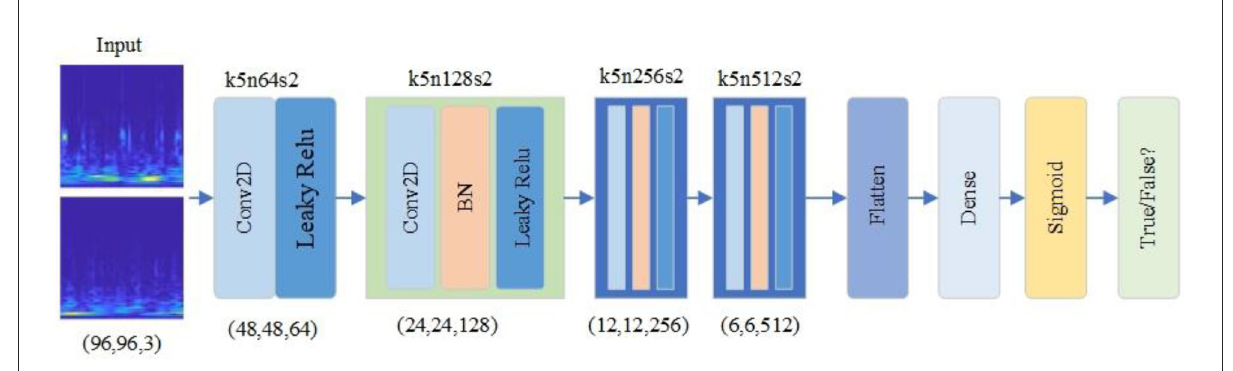
FIGURE5 RDCGAN discriminator